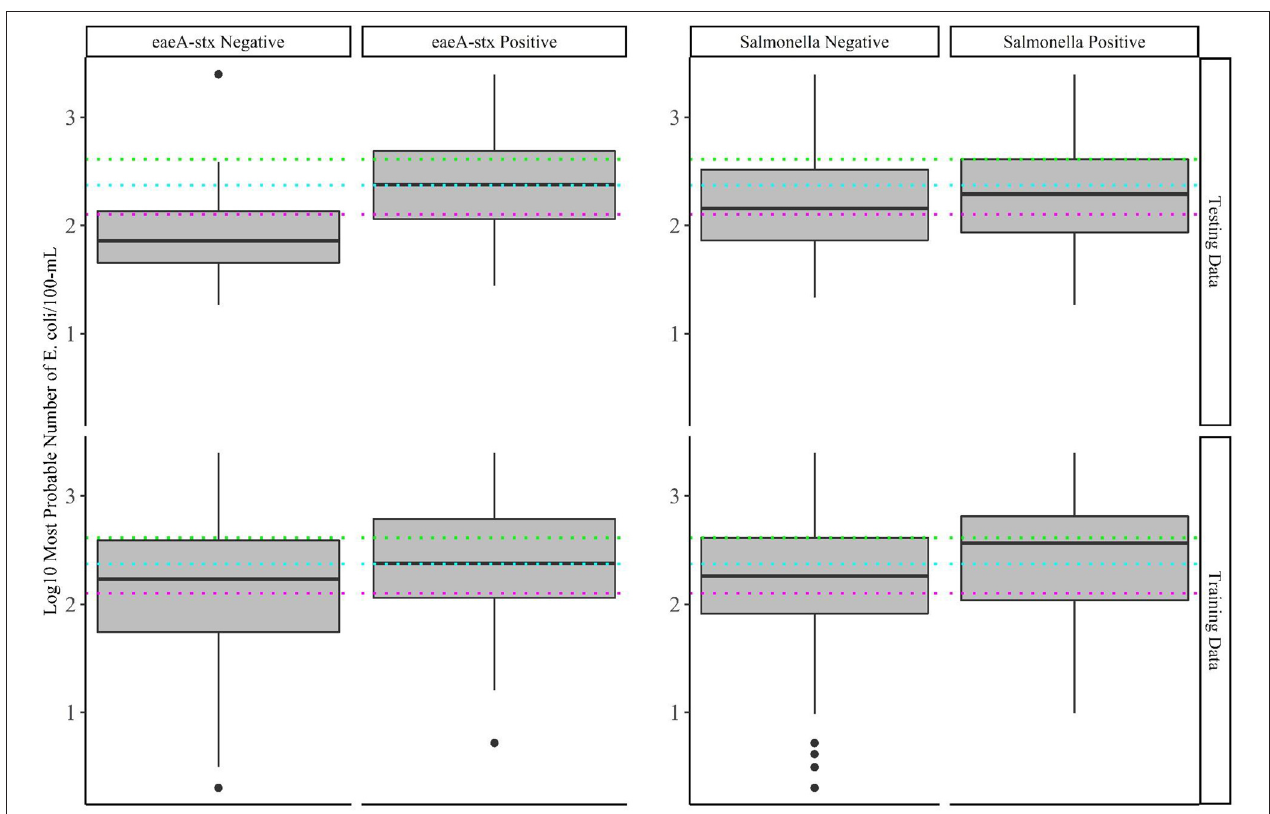
FIGURE 3 | Log 10 E. coli levels in training and test data samples that tested positive and negative for eaeA-stx and Salmonella . The colored lines represent the thresholds for agricultural water that were considered during development of the US Food Safety Modernization Act’s Produce Safety [126 MPN/100-MmL (pink), 235 MPN/100-mL (blue), and 410 MPN/100-mL